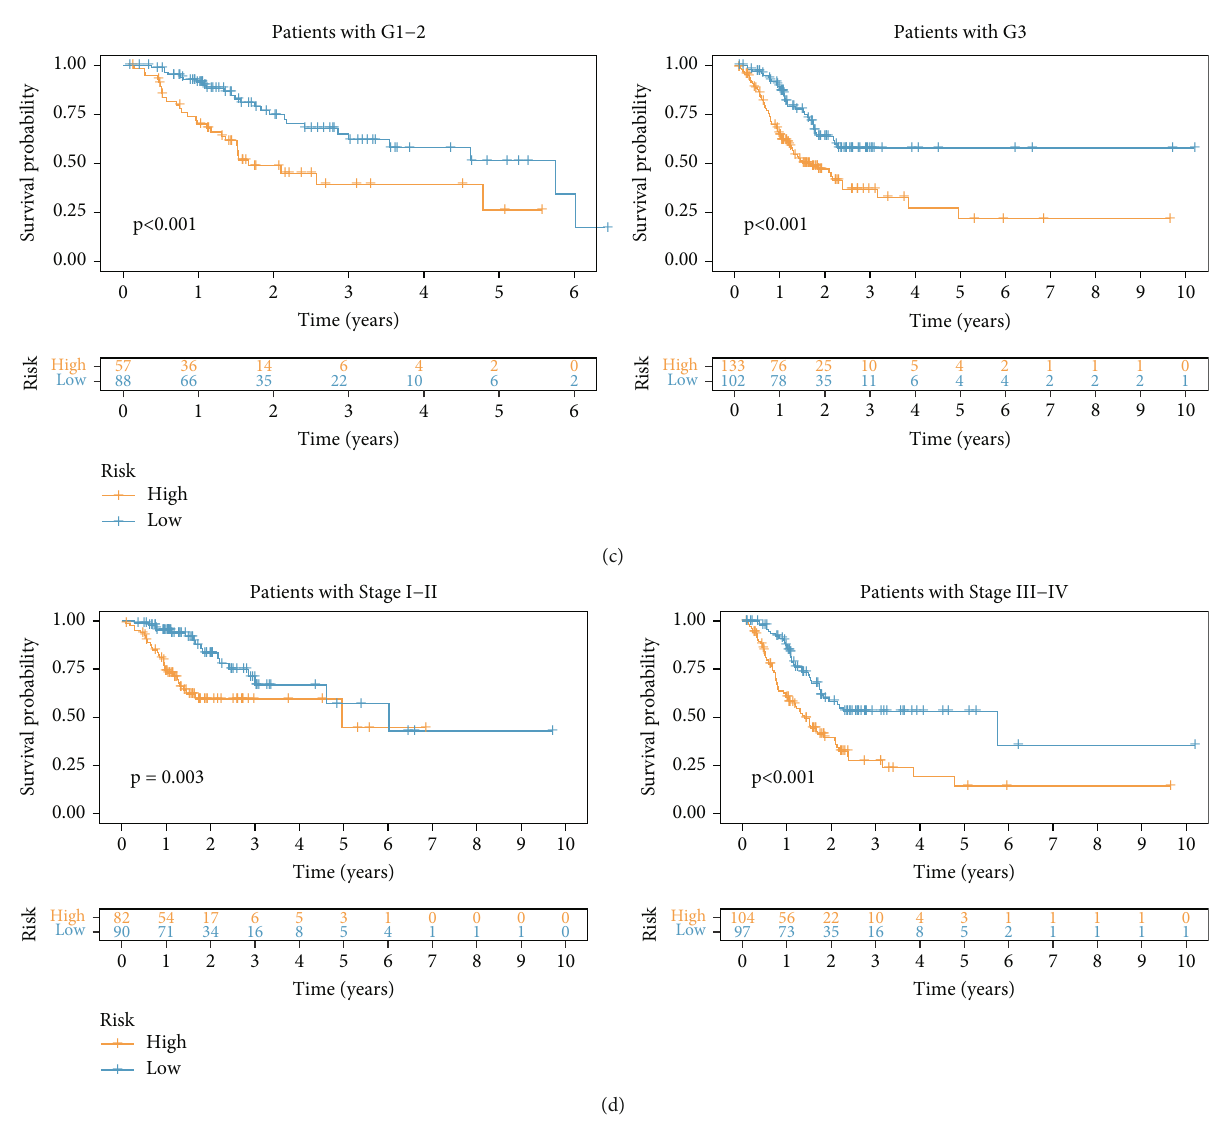
Figure 5: Survival analysis in high- and low-risk subgroups strati fi ed by (a) age, (b) gender, (c) grade, and (d)